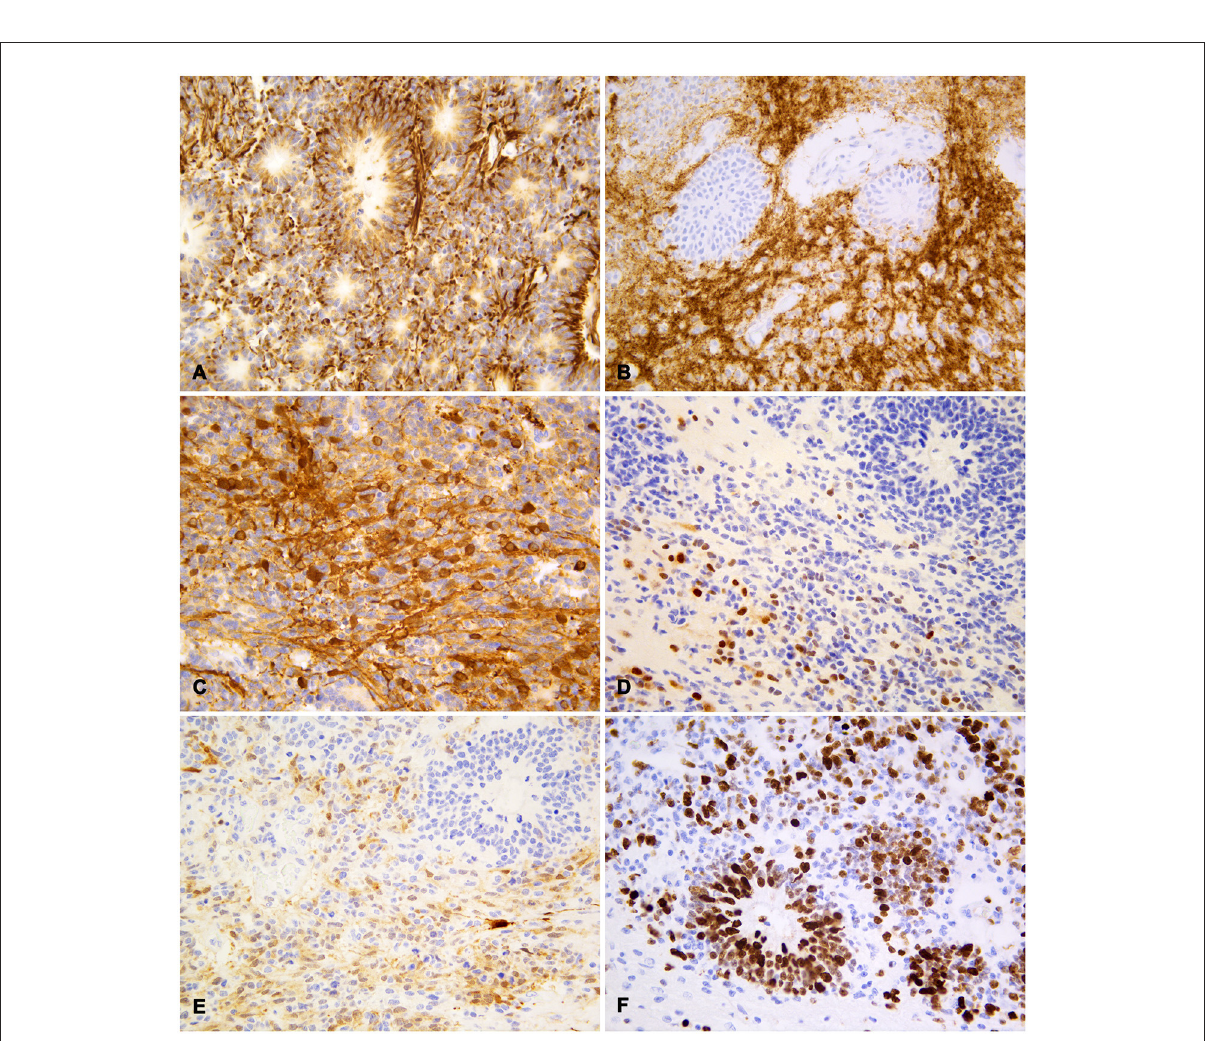
FIGURE3 Feline embryonal tumor with multilayered rosettes, neuropil-like areas and foci of neurocytic differentiation; immunohistochemistry. (A) Diffuse staining with vimentin both in rosettes and in undifferentiated neoplastic cells. (B) Strong synaptophysin expression in neuropil-like areas with negative rosettes. (C) Multifocal NSE expression by undifferentiated cells and cells with long fibrillar cytoplasmic projections. (D) Scattered cells with strong nuclear NeuN staining, less intense in the cytoplasm of rare cells. (E) Patchy cytoplasmic and nuclear S-100 protein expression in neoplastic cells with variable staining intensity. (F) Frequent Ki67 nuclear expression in rosette-forming and undifferentiated cells. Diaminobenzidine (DAB) chromogen; Mayer hematoxylin